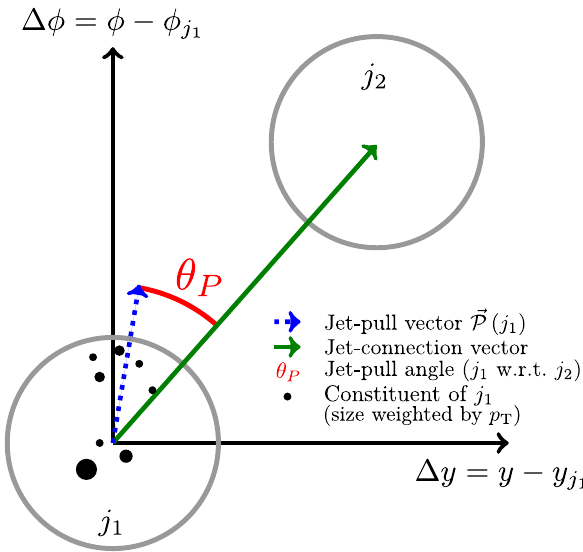
Fig. 3 Illustration of jet-pull observables for a dijet system. For a jet j 1 the jet-pull vector is calculated using an appropriate set of constituents (tracks, calorimeter energy clusters, simulated particles, …). The vari- able of particular sensitivity to the colour structure of j 1 with respect to j 2 is the jet-pull angle θ P which is the angle between the pull vector for